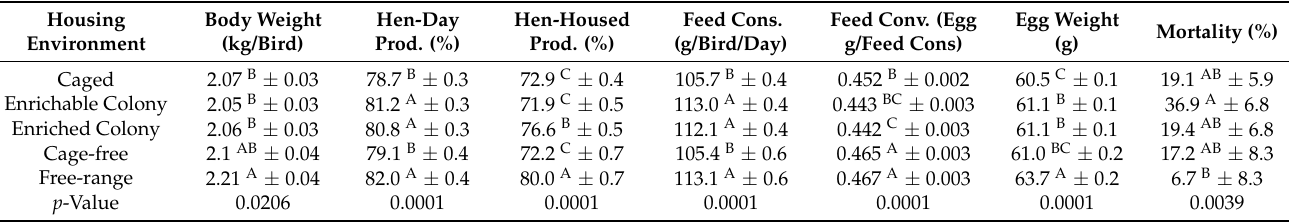
Table 4. Effect of housing system environment on production parameters of brown egg layers.